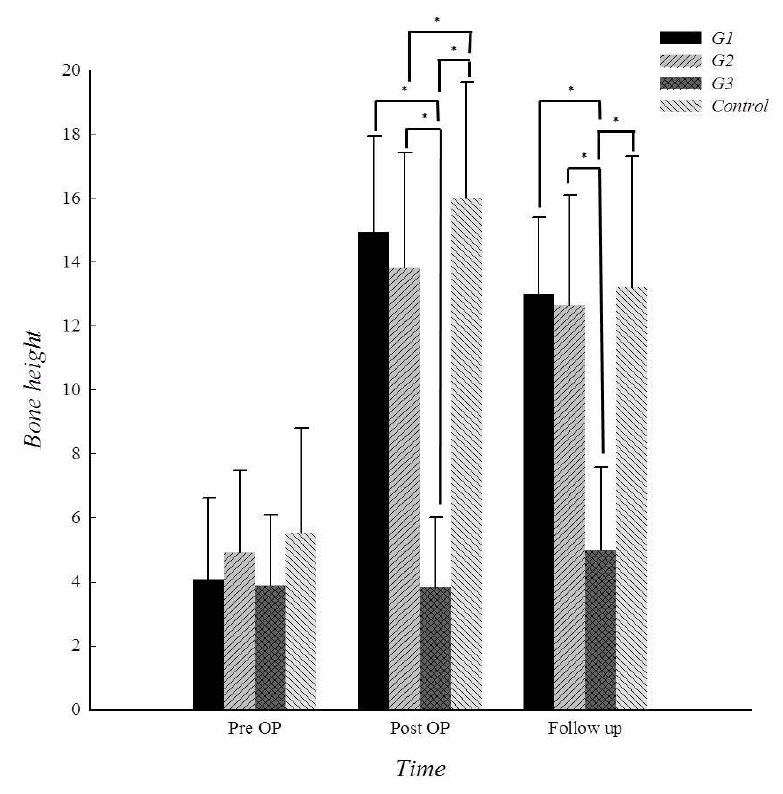
Figure 5. Graph of Tables 3 and 4. * indicates a significant difference in comparison with variable values at p < 0.016. Significance was determined using two-way repeated-measures ANOVA. Significance for pairwise comparison was determined with the Bonferroni post hoc test. Data are presented as means ± standard deviations.